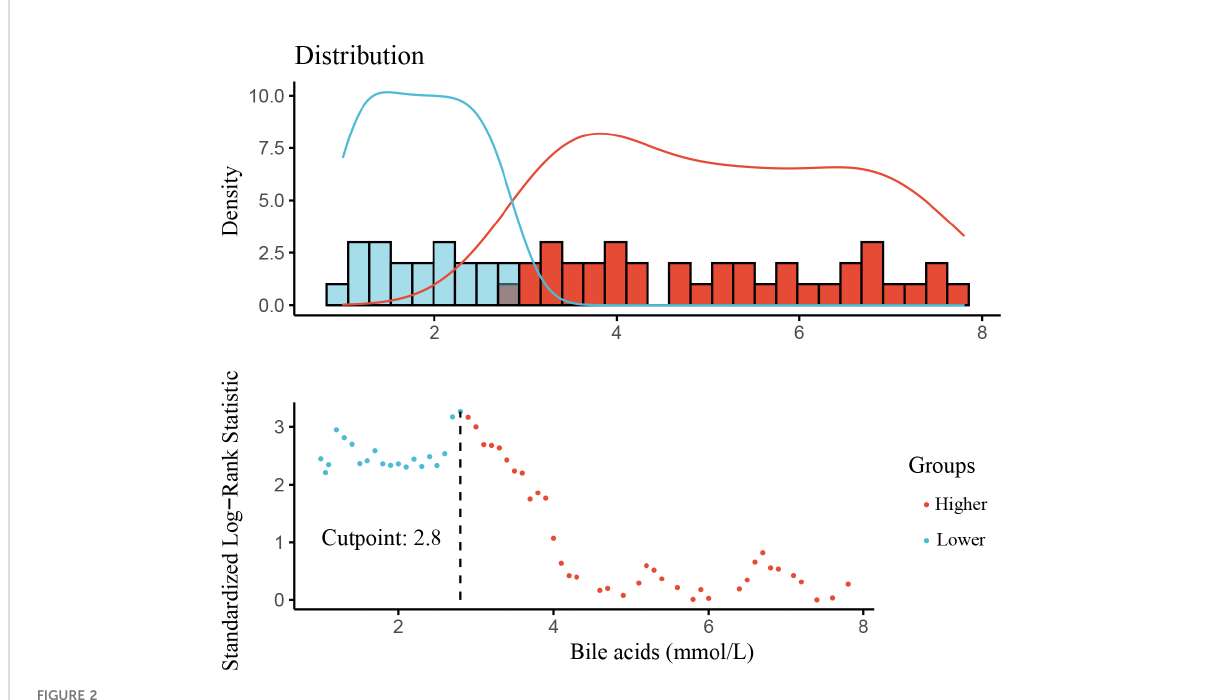
FIGURE 2 The optimal cut-point value of variables by restricted cubic spline.